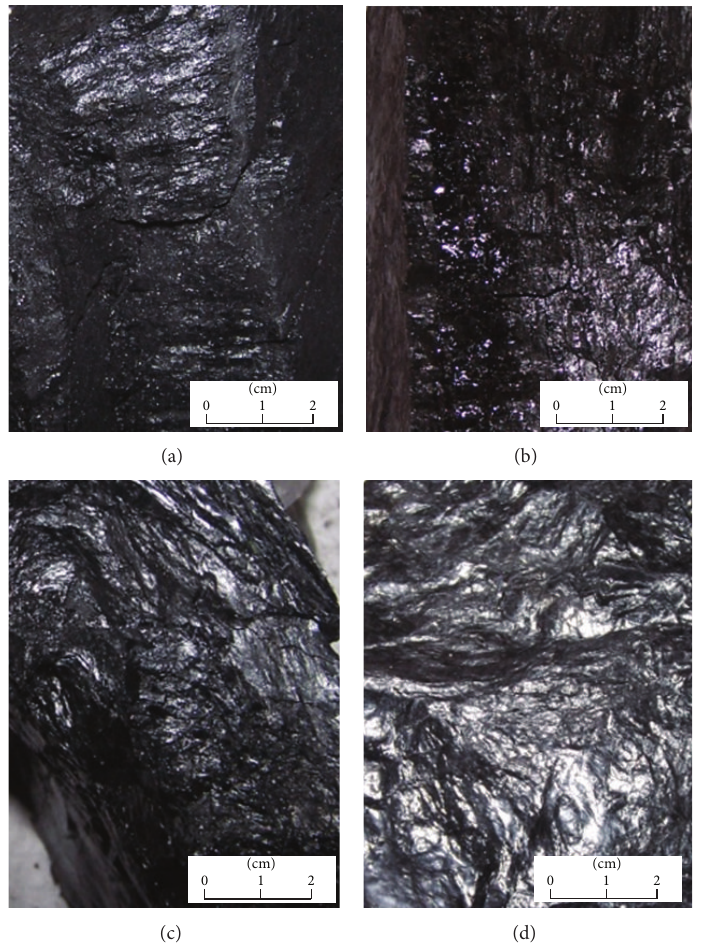
Figure 1: Hand specimen images of deformed coal, (a) weak brittle deformed coal (Y04); (b) strong brittle deformed coal (H12); (c) weak ductile deformed coal (L04); (d) strong ductile deformed coal (H09).